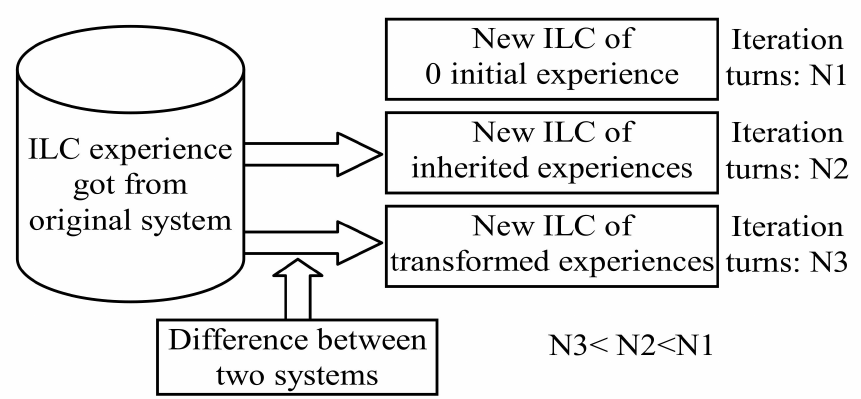
Figure 1. Iterative Learning Control (ILC) with Different Initial Experiences.